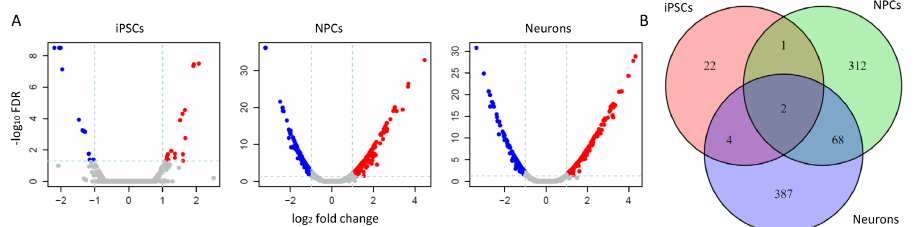
Figure 1. Differential expression analysis in three cell types. ( A ) volcano plots showed the significant DEGs with cutoff |log2FC| > 1 and FDR < 0.05. Blue points represent unexpressed genes, while red points refer to overexpressed genes in different neural cells types. ( B ) The unique and common DEGs among the three cell types demonstrated the distinct gene expression change patterns in iPSCs compared to NPCs and neural cells.